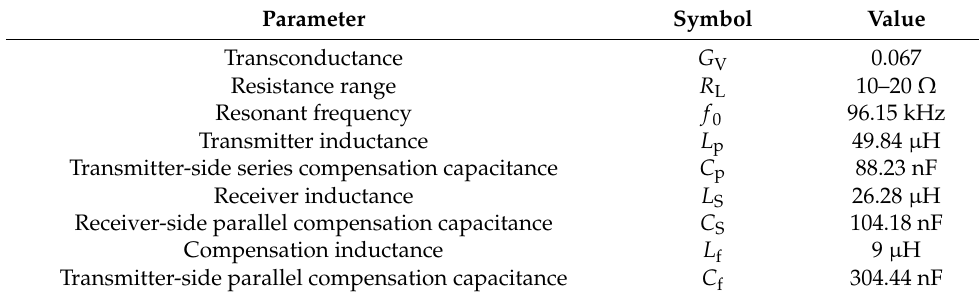
C S Figure 8. Experimental prototype. Table 3. System Parameters. Note